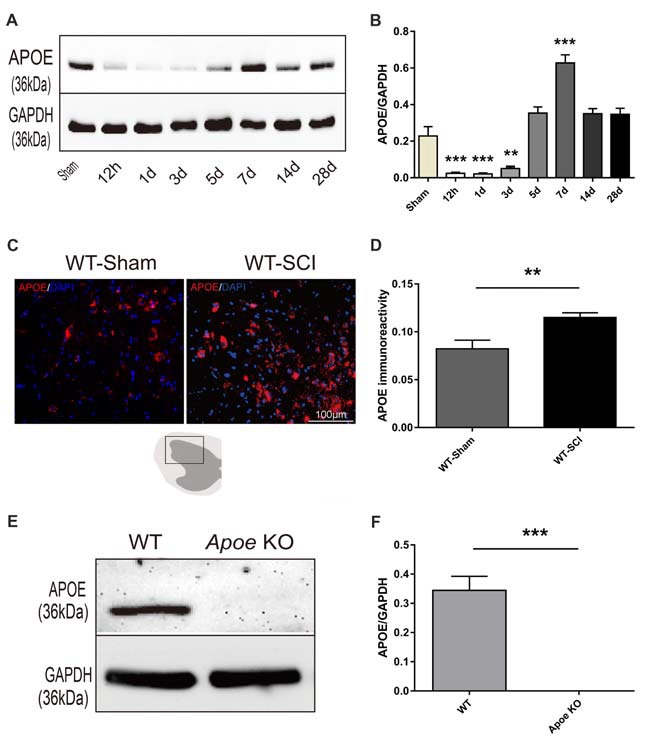
The temporal expression of Apolipoprotein E (APOE) protein after spinal cord injury (SCI) and identification of Apoe KO mice. (A) Representative western blots (WBs) of APOE and GAPDH expression in the lesion site after SCI. (B) Statistical analysis of WBs of APOE expression in WT mice after SCI. Data are expressed as mean ± SEM of three independent experiments (n = 6 per group). **p < 0.01, ***p < 0.001, Sham vs. 12 h, p = 0.0002, Sham vs. 1 day, p = 0.0001, Sham vs. 3 days, p = 0.0021, Sham vs. 7 days, p < 0.0001, one-way analysis of variance (ANOVA) followed by Tukey’s post hoc test. (C) Representative immunofluorescent images of APOE at the lesion epicenter in Sham and SCI group 7 days post-injury. (D) Statistical analysis of APOE immunoreactivity after SCI. Four transverse sections were measured optical intensity at ± 400 μm, ±700 μm from rostral and caudal to the injury site per spinal cord. Data are expressed as mean ± SEM of three independent experiments (n = 6 per group). **p < 0.01, Sham vs. 7 days, p = 0.0047, Student’s t-test, Scale bars = 100 μm. (E) APOE expression in the spinal cord was detected by WBs from WT and Apoe KO mice. (F) Statistical analysis of APOE and GAPDH expression both in WT and Apoe KO mice. Data are expressed as mean ± SEM of three independent experiments (n = 6 per group). ***p < 0.001, WT vs. Apoe KO, Student’s t-test.